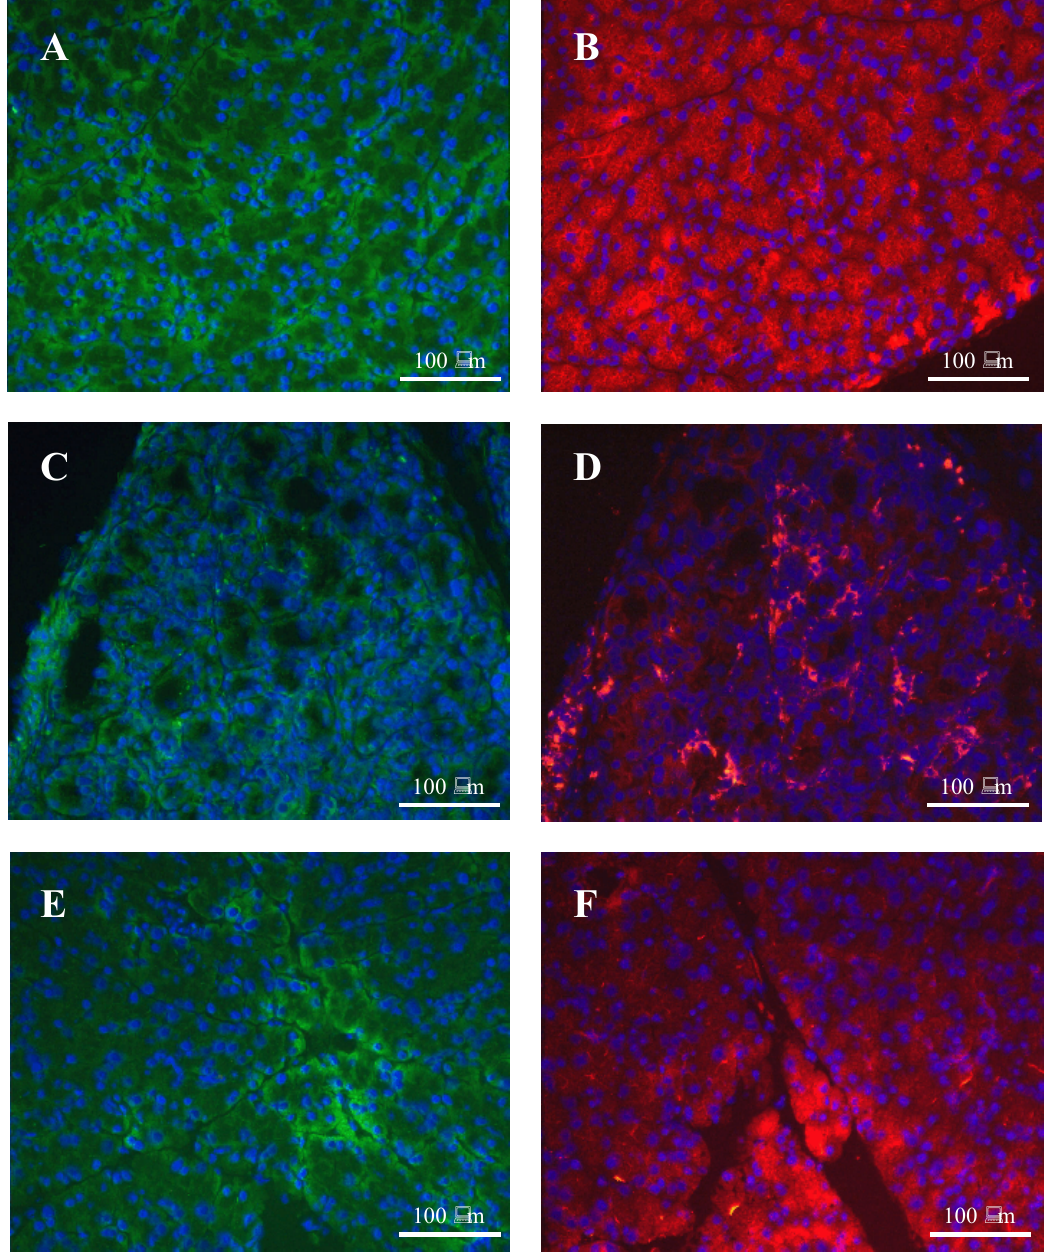
Fig. 1 Immunohistochemical staining of vigilin (A,C,E) and trypsin(ogen) (B,D,F). Sec- tions of rat pancreas were immunostained with an affinity-purified polyclonal antiserum against vigilin (FP-III) and trypsinogen, after induction of pancreatitis by dibutyltin dichloride (DBTC). Micrographs were obtained by fluorescence